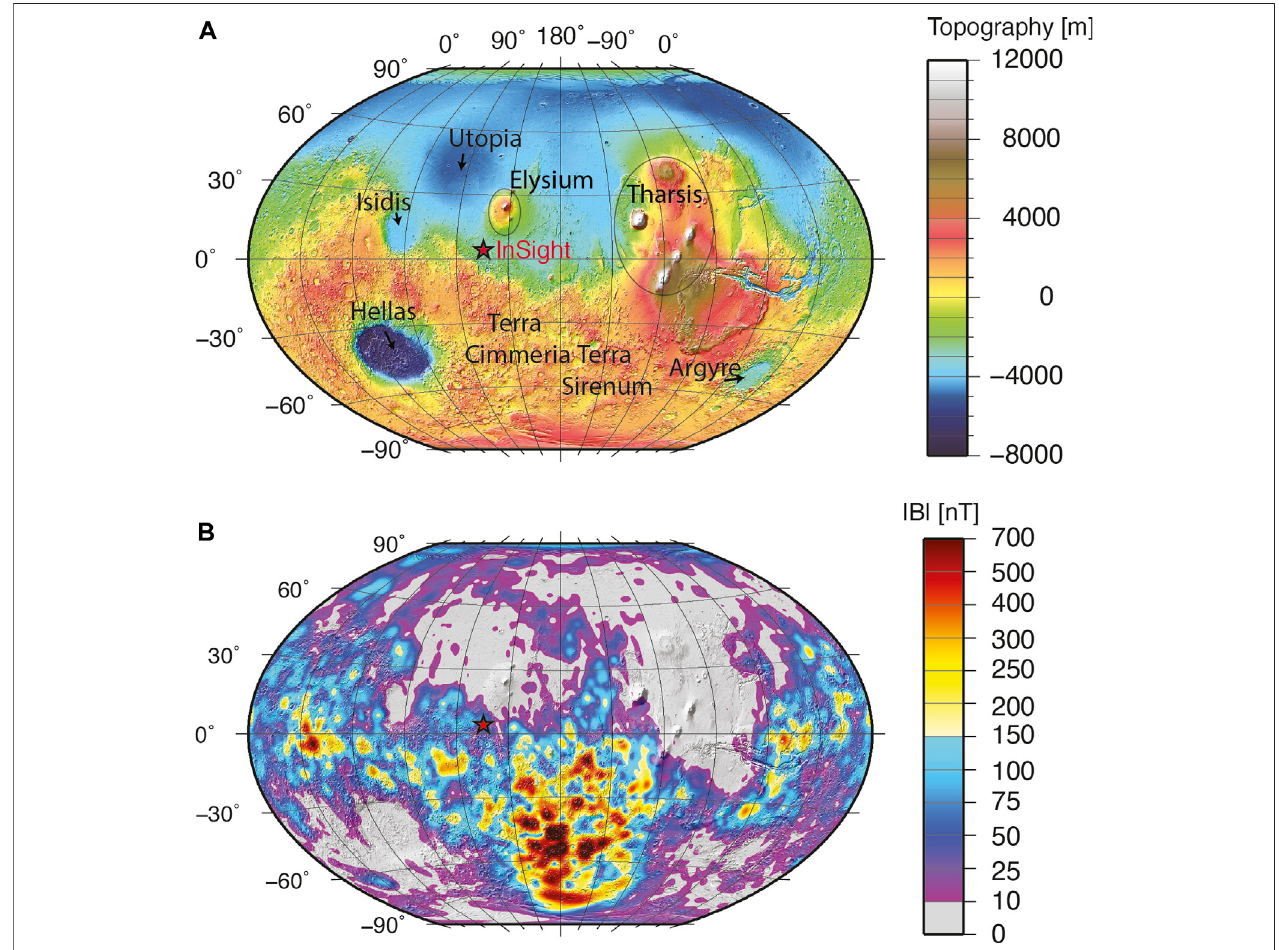
FIGURE 1 | (A) MOLA topography showing the major physiographic features on Mars including the North-South dichotomy, the impact basins, Hellas, Utopia, Isidis and Argyre (black arrows), and two major volcanic regions, Tharsis and Elysium (black circles). The InSight landing site is shown (red star). (B) Magnetic fi eld amplitude in nT predicted at 130 km altitude after (Langlais et al.,